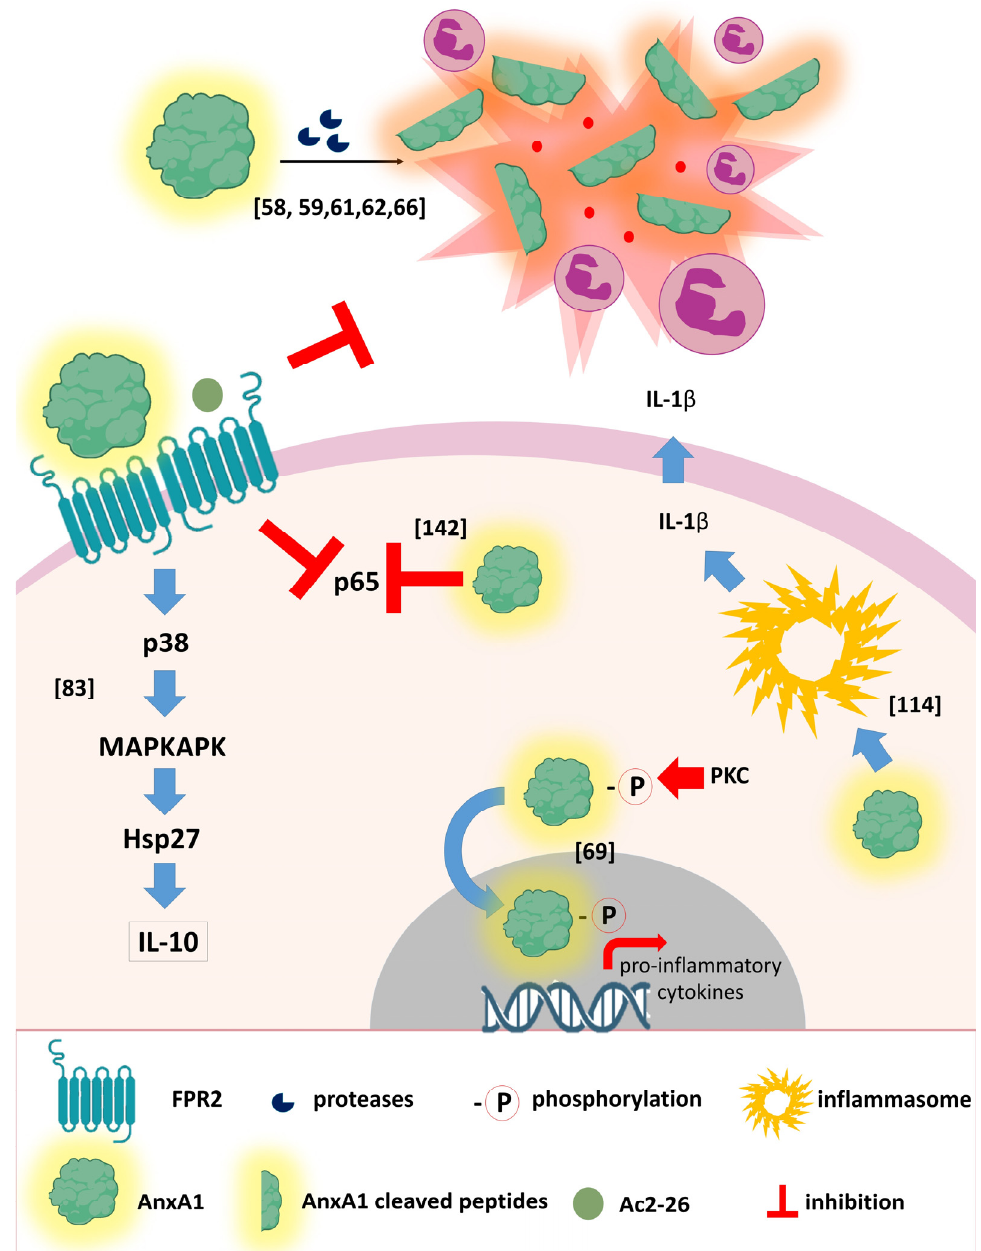
Figure 1. The intricate role of AnxA1 in different signaling pathways. As a pleiotropic molecule, AnxA1 can stimulate or inhibit different signaling pathways in the cytoplasm of the cells, leading to anti- or proinflammatory effects. For instance, it was demonstrated that the binding of AnxA1 and Ac2-26 occurs preferentially to FPR2 homodimers, activating signaling pathways dependent on p38 and Hsp27, leading to IL-10 production. Conversely, if phosphorylated by PKC at Serine 27 and translocated to the nucleus, AnxA1 can stimulate the transcription of proin fl ammatory cytokines. Additionally, di ff erent studies indicate that the peptides obtained from the cleavage of AnxA1 are certainly related to in fl ammation in the tissue and neutrophil in fi ltrate. AnxA1 can also activate the NLRP3 in fl ammasome to induce IL-1 β release. Moreover, the binding of AnxA1 to the FPR2 recep- tor leads to the inhibition of NF- κ B subunit p65, whilst solely in the cytoplasm, AnxA1 can inhibit this same protein. Evidence for each of these phenomena are referenced within the fi gure [58,59,61,62,66,69,83,124,142].